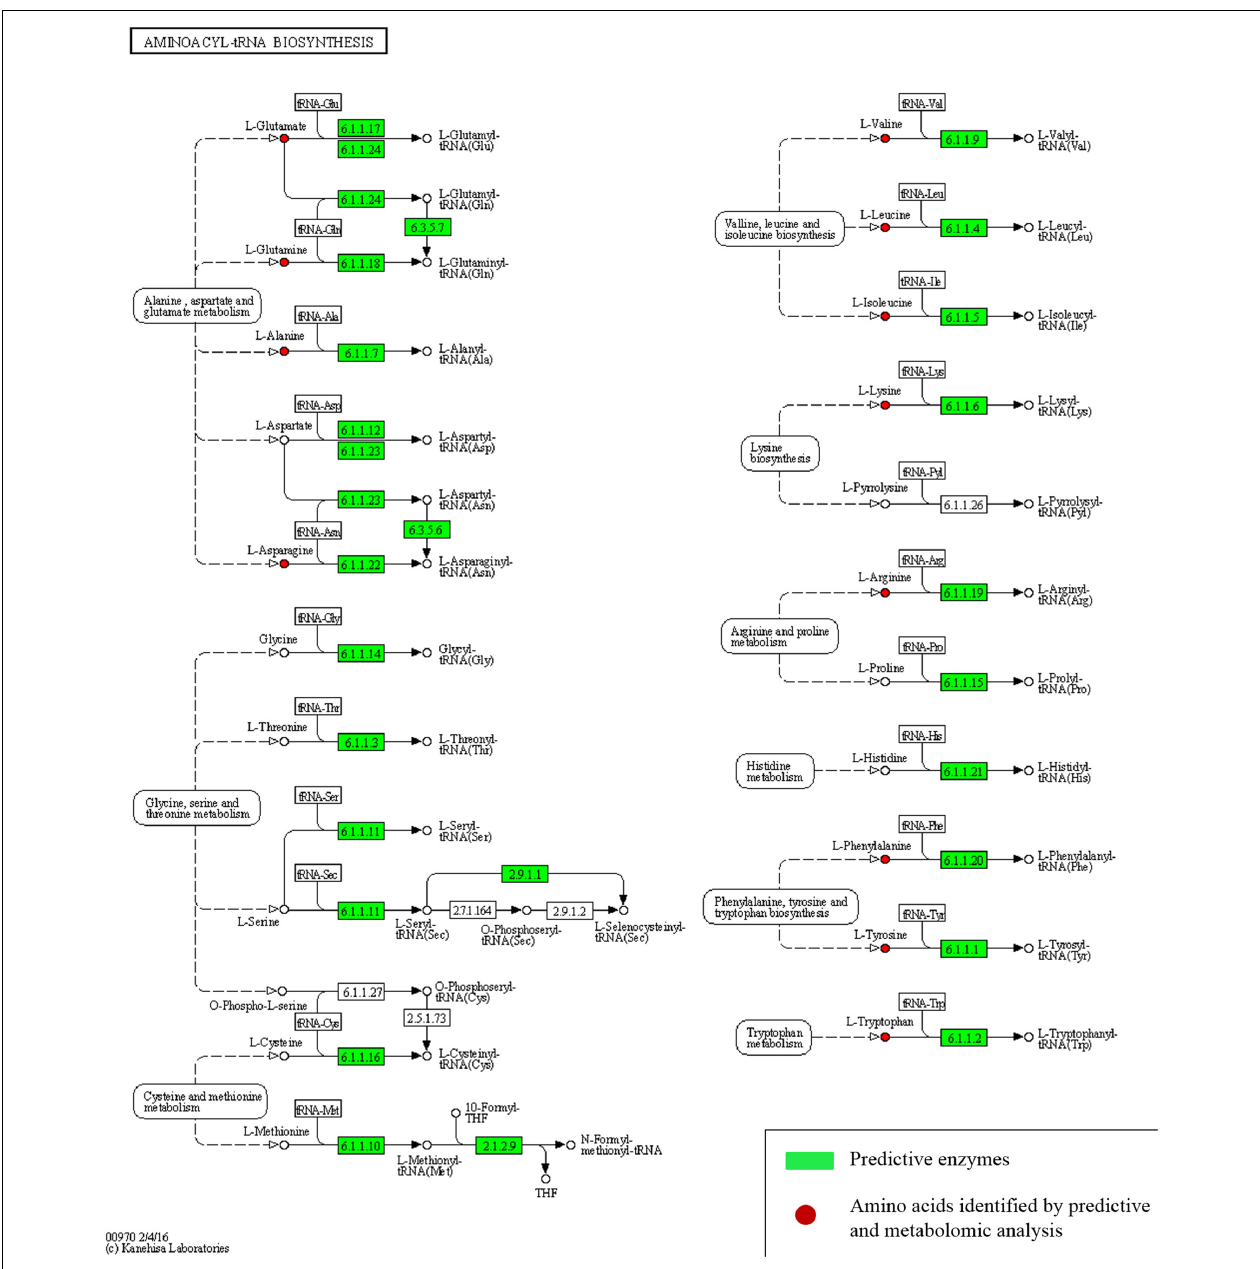
FIGURE 6 | Predictive enzymes involved in aminoacyl-tRNA biosynthesis of different amino acids.